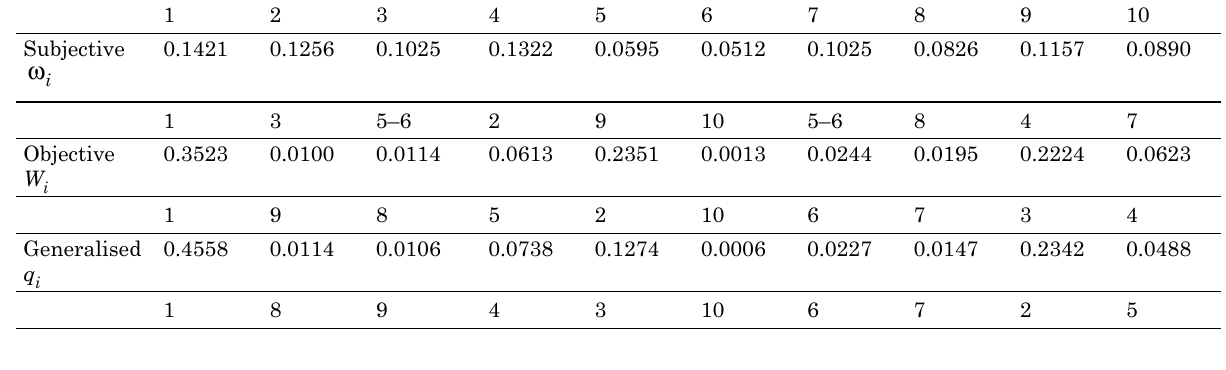
Table 4. Weights of subjective, objective and generalised indices